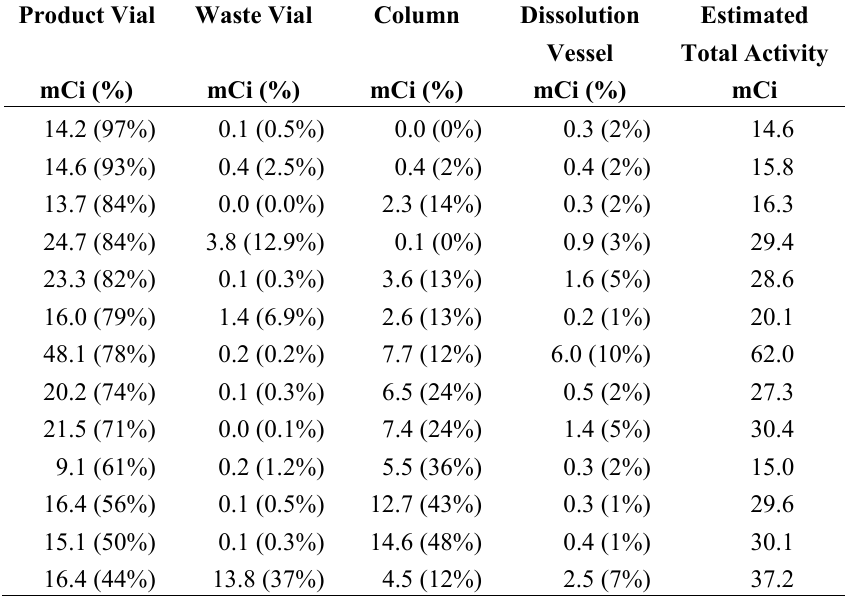
Table S3. Summary of results from productions of 89 Zr (sorted highest to lowest by recovery percentages).